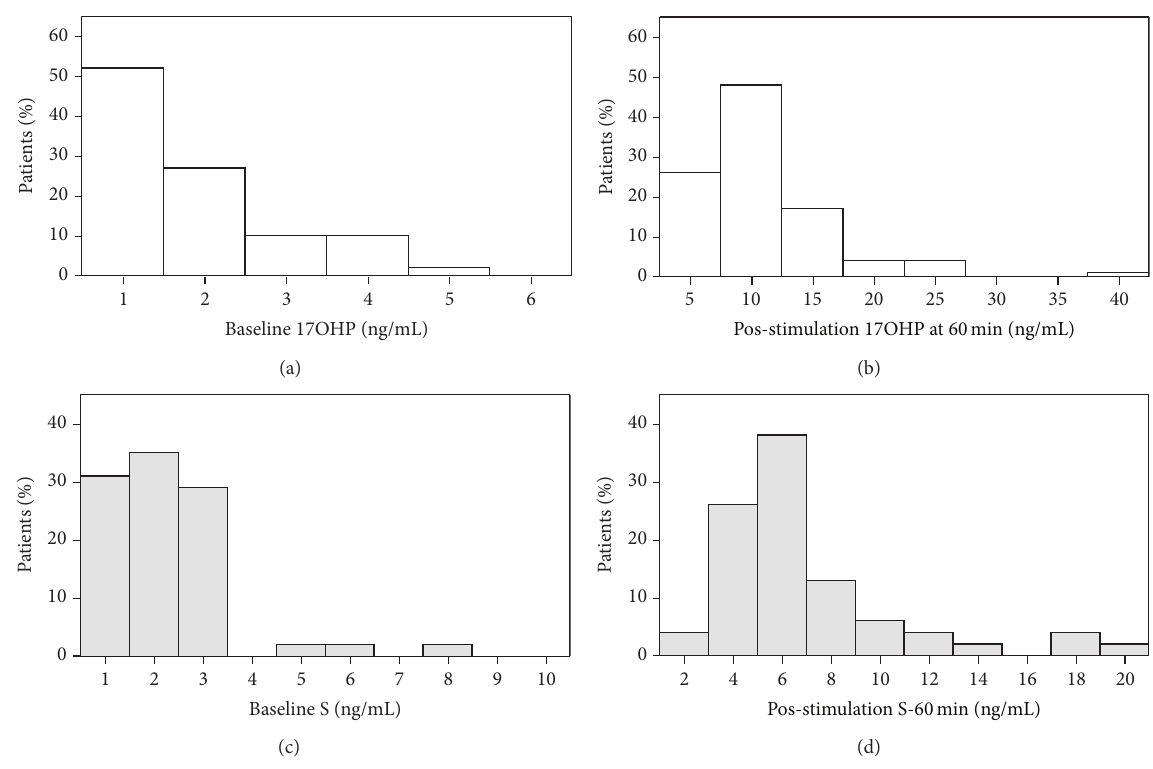
Figure 2: (a) Histogram of baseline 17-hydroxyprogesterone (17OHP) distribution. (b) Histogram of 17-hydroxyprogesterone (17OHP) distribution at 60 min after 250 𝜇 g of cosyntropin iv. (c) Histogram of baseline 11-deoxycortisol (S) distribution. (d) Histogram of 11- deoxycortisol (S) distribution at 60min after 250 𝜇 g of cosyntropin iv.